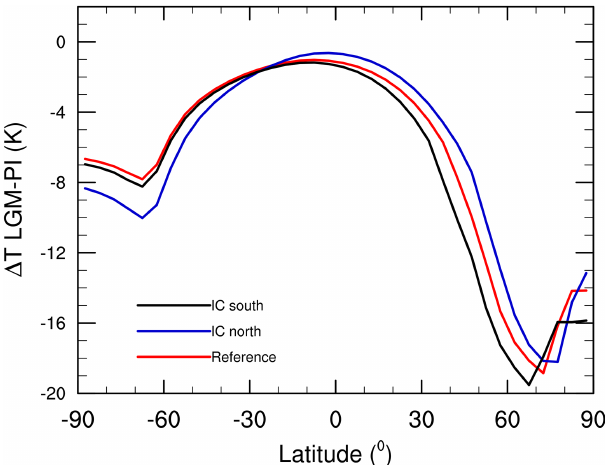
Figure 7. Modelled LGM–PI atmospheric temperature difference, for the reference run (red), a run with the NH ice sheets placed 5 ◦ more to the north (blue), and a run with the NH ice sheets placed 5 ◦ more to the south